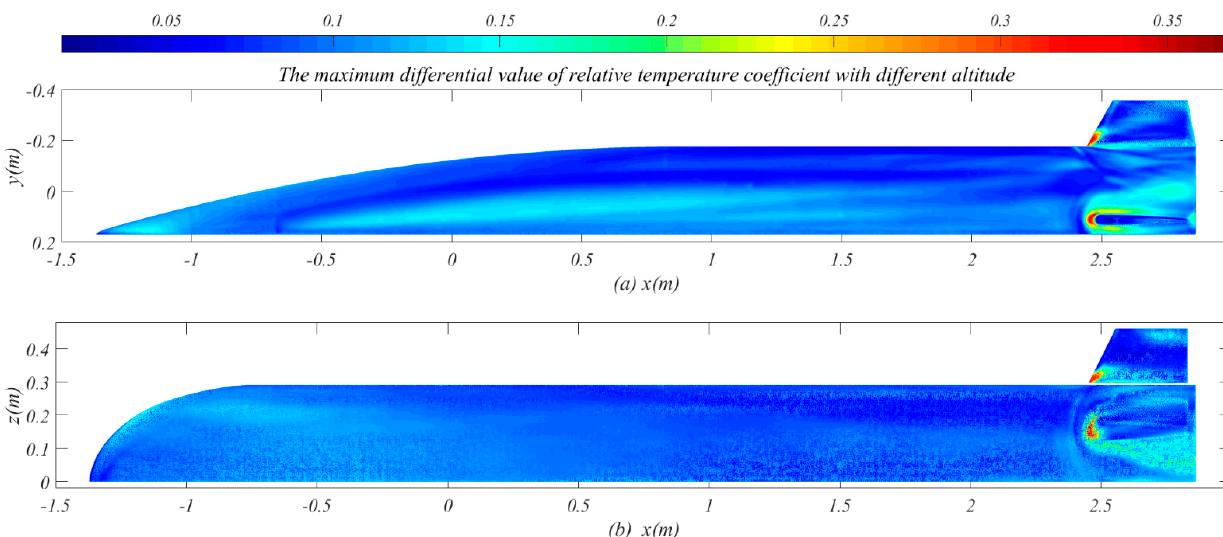
Figure 11. The maximum differential value of relative temperature coefficient with different altitude: ( a ) the side view of aircraft; ( b ) the top view of aircraft.